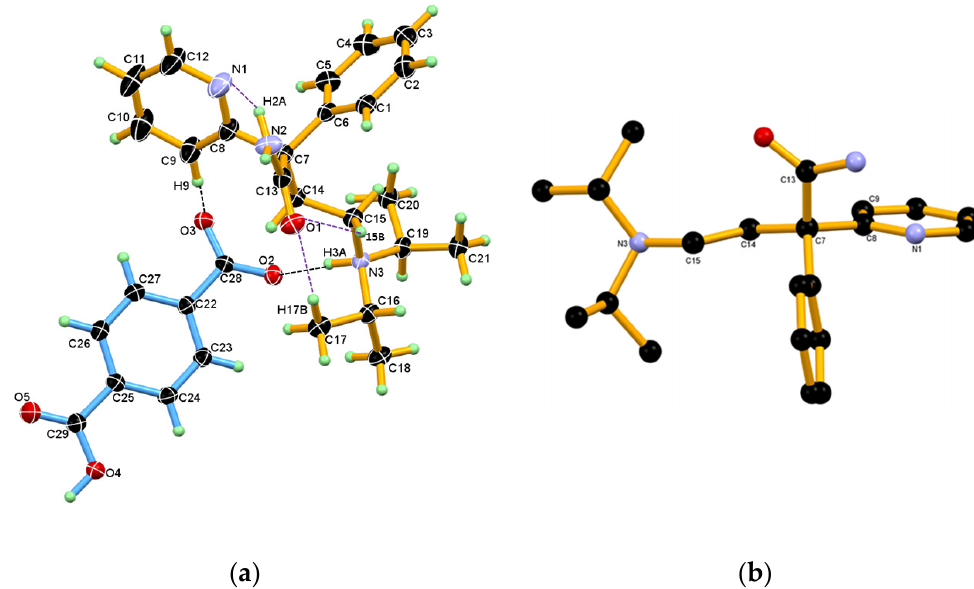
Figure 2. ( a ) ORTEP diagram of DPA:TA salt showing the atom numbering scheme. The thermal ellipsoid is drawn at 50% Figure 2. ( a )ORTEP diagram DPA:TA Salt showing the atom numbering scheme. Thermal ellipsoid drawn at 50% proba- bility level, and H-atoms are shown as small spheres with arbitrary radii. Association between the salt pair in asymmetric probability level, and H-atoms are shown as small spheres with arbitrary radii. The association between the salt pair in unit of DPA:TA salt shown by black dotted line and in this association only carboxylate group of TA involved. Protonated the asymmetric unit of DPA:TA salt is shown by the black dotted line and, in this association, only the carboxylate group DPA in salt displaying intramolecular N2-H2A ∙∙∙ N1, C15-H15B ∙∙∙ O1, C17-H17B ∙∙∙ O1 hydrogen bond and shown by purple color dotted line. ( b ) Conformation of protonated DPA in salt and torsional angle τ 1 - C7-C14-C15-N3, τ 2 – C8-C7-C14-C15, of TA is involved. Protonated DPA in salt displaying the intramolecular N2-H2A ··· N1, C15-H15B ··· O1, C17-H17B ··· O1 τ 3 –C9-C8-C7-C14, τ 4 – C13-C7-C14-C15. hydrogen bond is shown by the purple dotted line. ( b ) Conformation of protonated DPA in salt and torsional angle